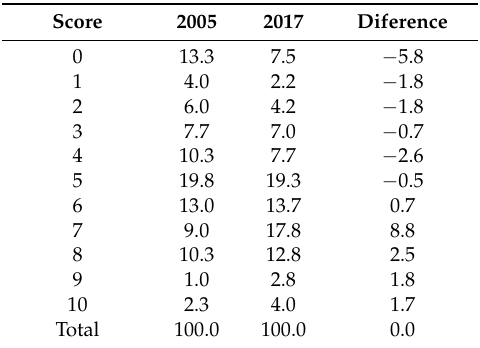
Table 6. Perception of the town council actions in the residential area,